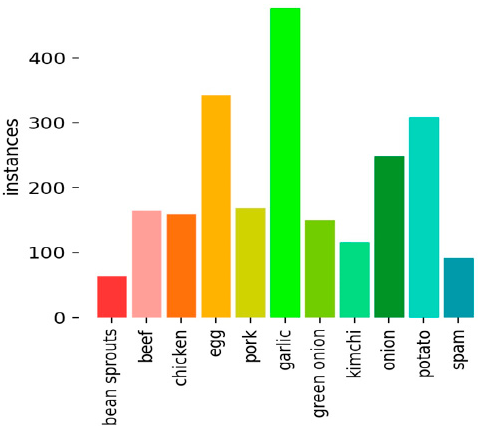
Figure 8. Training dataset containing 11 food ingredients.